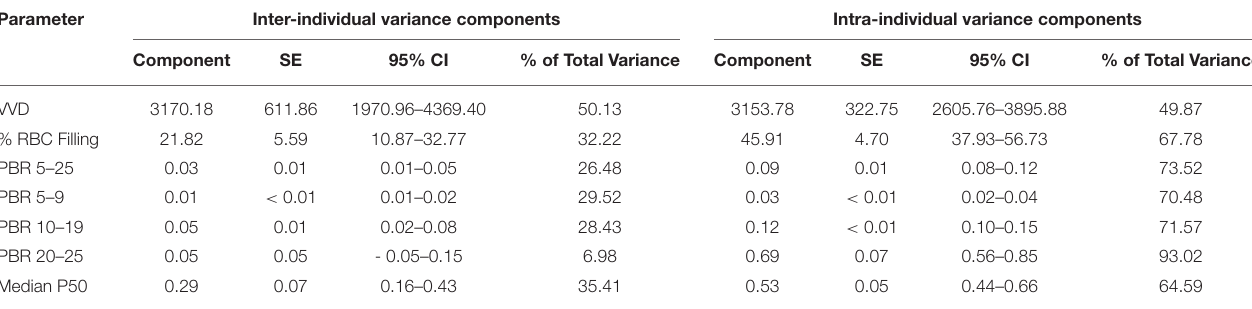
TABLE 4 | Variance component estimates for GlycoCheck ® parameters in a population of healthy cats ( n = 101). Parameter